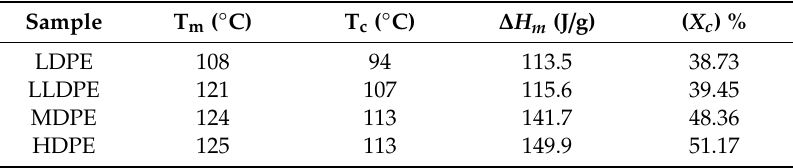
Figure 2. ( a ) Differentialscanning calorimetry (DSC) cooling curvesand ( b ) heating curves of four kinds of polyethylene. Table 1. Melting process parameters of four kinds of polyethylene.